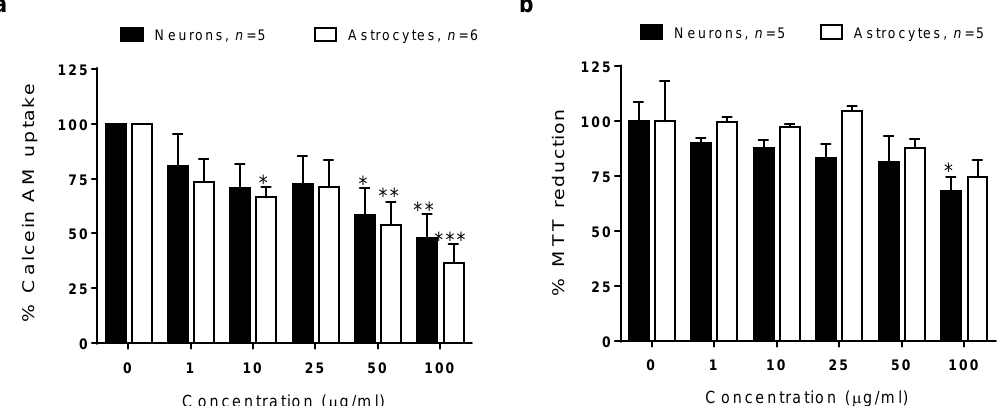
Figure 8. Viability of astrocytes and neurons after exposure to SiO 2 -NPs. The neurons and astrocytes were exposed to 0–100 µ g / mL SiO 2 -NPs. ( a ) Calcein-AM uptake in neurons and astrocytes. ( b ) MTT reduction in neurons and astrocytes. Data are presented as mean ± SEM of five to six independent experiments with three technical replicates. Statistical analysis was by two-way ANOVA followed by Bonferroni’s post hoc test. * p < 0.05, ** p < 0.01, *** p < 0.001 vs. control.